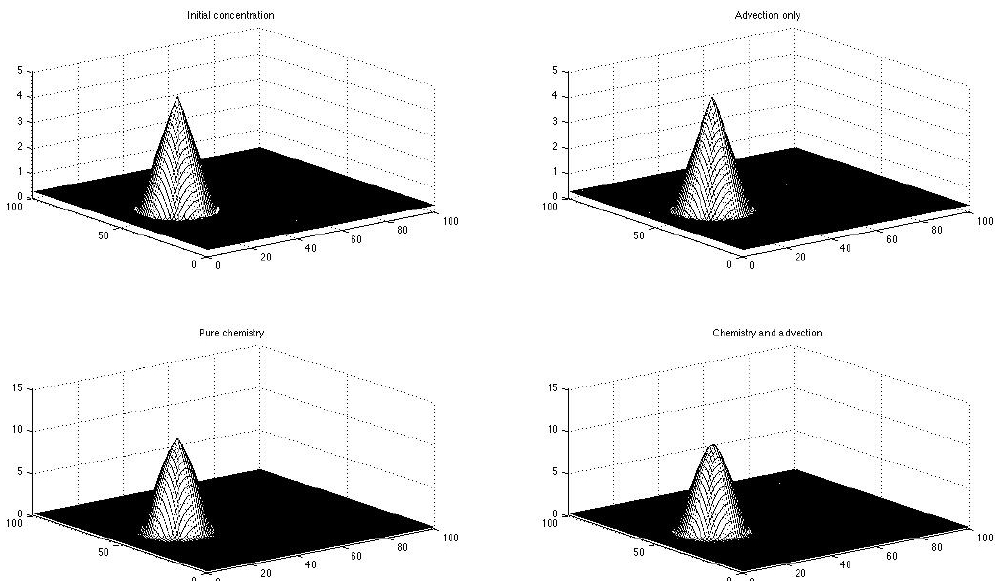
Fig. 1. Rotation test for ASD using the rotating cone for NO 2 with urban conditions and resolution 1 1, with 1t = 90s, 1x = 1 . 0, and C = 0 . 327. The results are given for the initial condition (top left) and model runs with pure advection (top right), pure chemistry (bottom left), and combined chemistry and advection (bottom right). The minimum and maximum values for the respective plots are: Top left: min=0.2406, max=4.729. Top right: min=0.2221, max=4.683. Bottom left: min=0.1317, max=11.22. Bottom right: min=0.106,